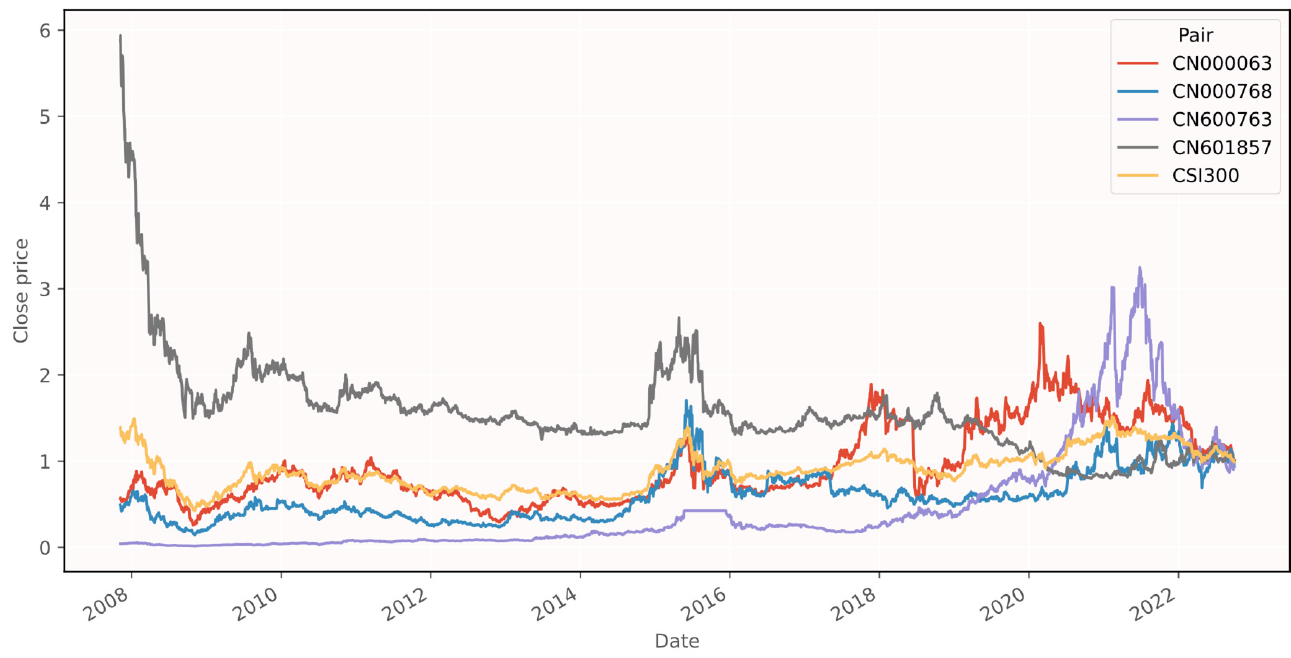
Figure 5. The closing price changes of Portfolio 1.